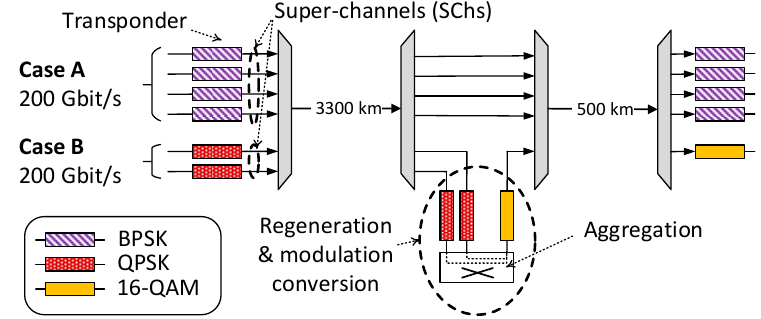
Figure 1. Provisioning of a 200 Gbit/s lightpath without back-to-back (B2B) regeneration (case A) and with B2B regeneration (case B). The following modulation formats are applied: BPSK (Binary Phase Shift Keying), QPSK (Quadrature Phase Shift Keying), and 16-QAM (Quadrature Amplitude Modulation).